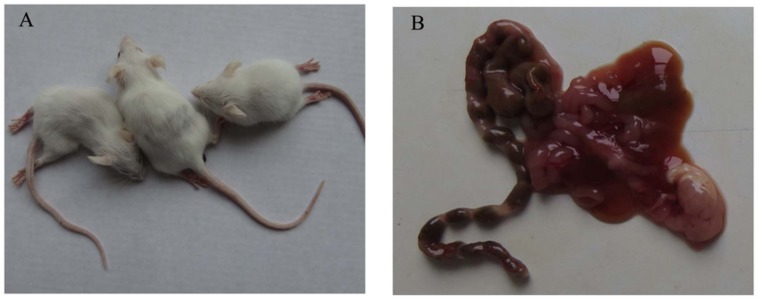
Clinical signs and gross lesions of mice infected with TMUV by i.c.
(A) Three mice displayed paralysis of two hind legs, crawl at 8 dpi. (B) Liquefaction and hemorrhage of intestine were visible in the dead mice.